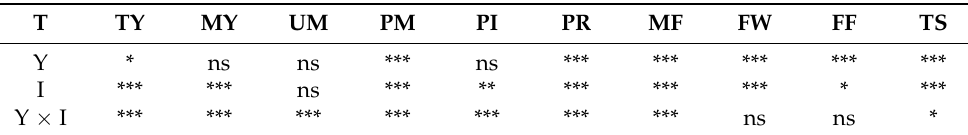
Table 3. Analysis of variance for tomato traits recorded under nine irrigation levels during the two growing